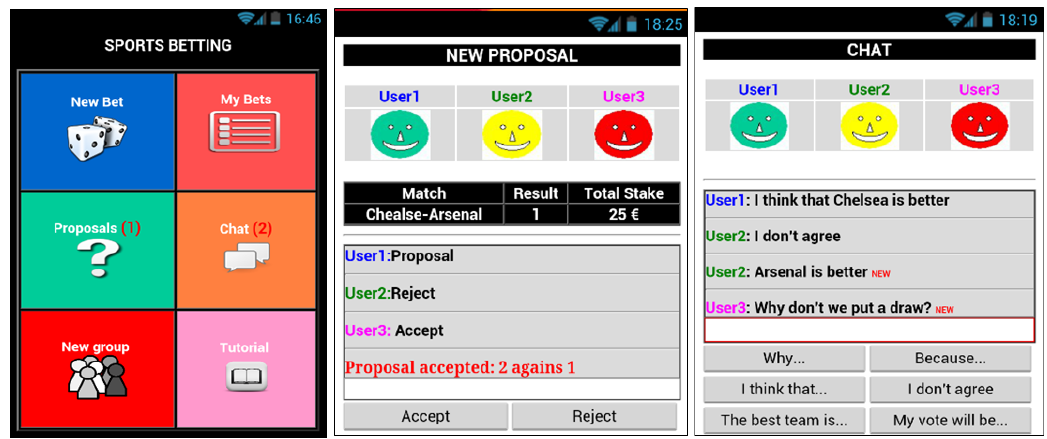
Figure 3. User interface of the groupware system. Main user interface ( left ), chat tool ( center ), voting panel ( right ).